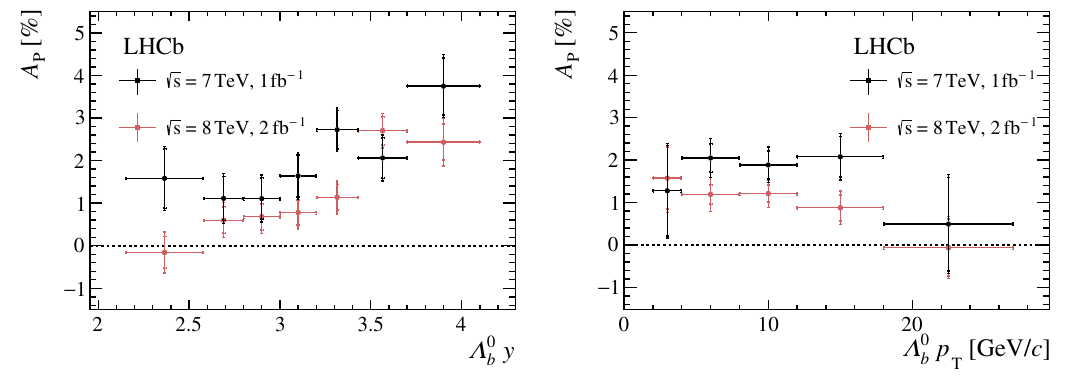
Figure 9 . Measured (cid:3) 0 production asymmetry versus (left) rapidity and (right) transverse mo- b mentum. The uncertainties are the quadratic sums of statistical and systematic uncertainties. The results in neighbouring intervals are